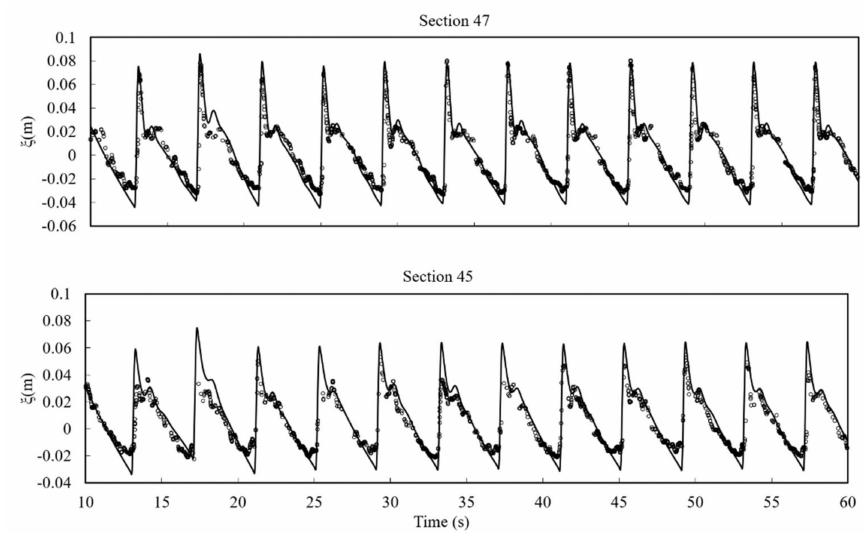
Figure 9. Comparison of simulated and measured free surface elevations for case T2 (plunging